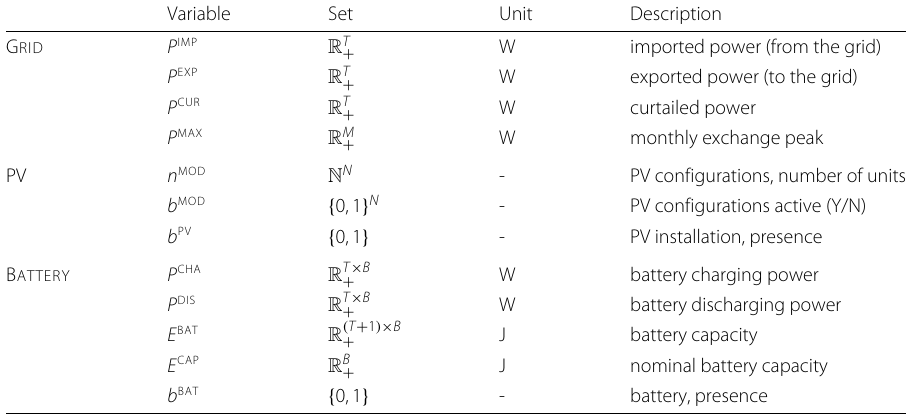
efficiency (η CHA , DIS ) , charging and discharging C-rate (γ CHA , DIS ) and finally a specific